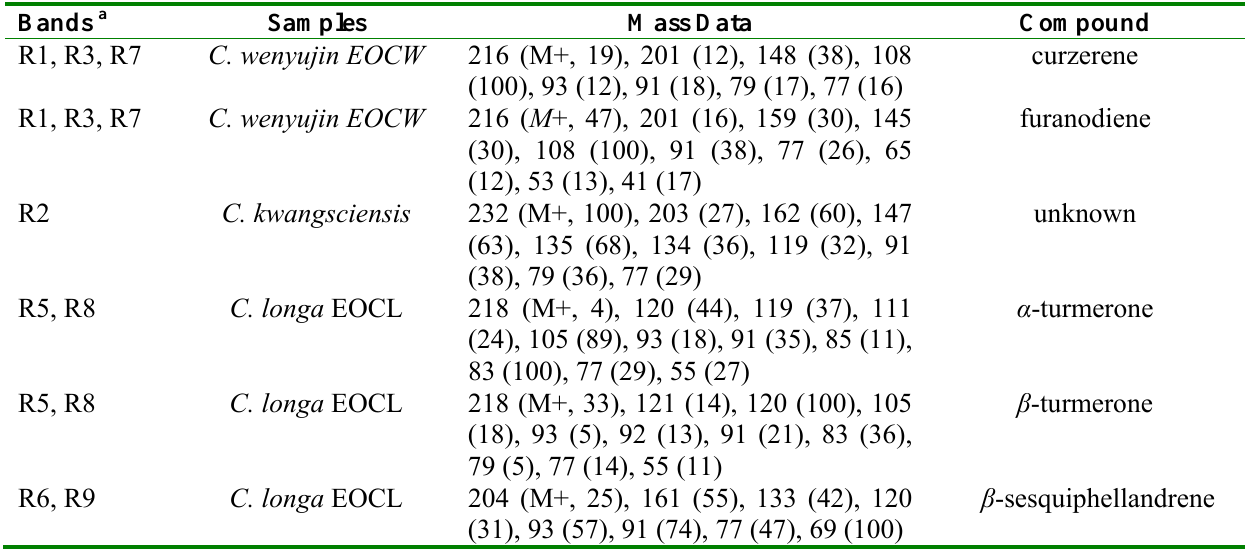
Table 1. The compounds in the active bands that contribute to antioxidant activity of the tested samples.